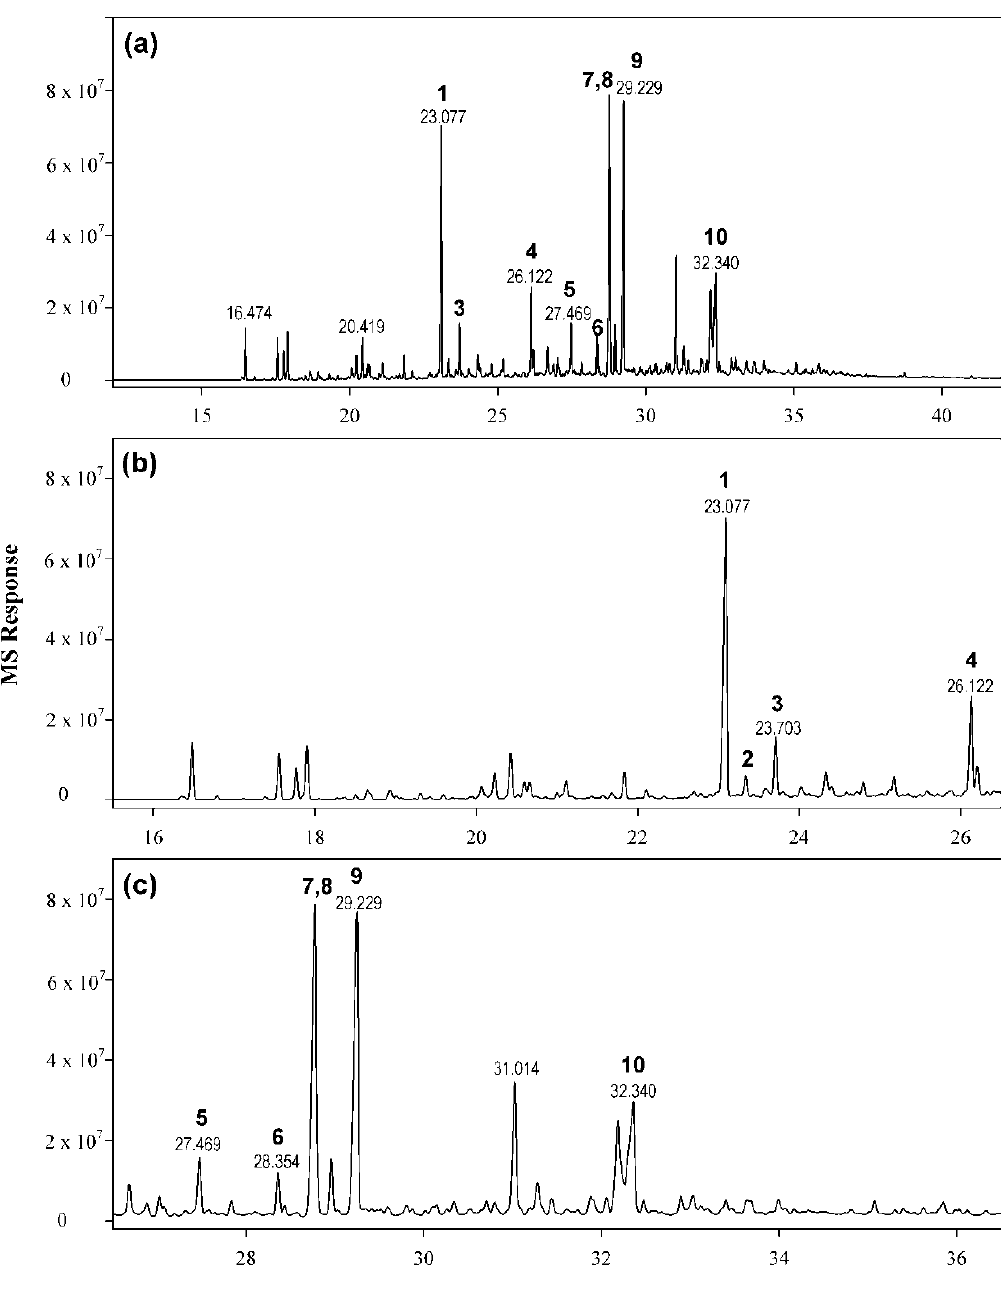
Figure 2. Characterization of the volatile fraction of the crude methanol extract of myrrh. ( a ) Total Ion Chromatogram (TIC) MS chromatogram of MME; ( b ) expansion between 16 and 26 minutes, ( c ) expansion between 26 and 37 minutes.